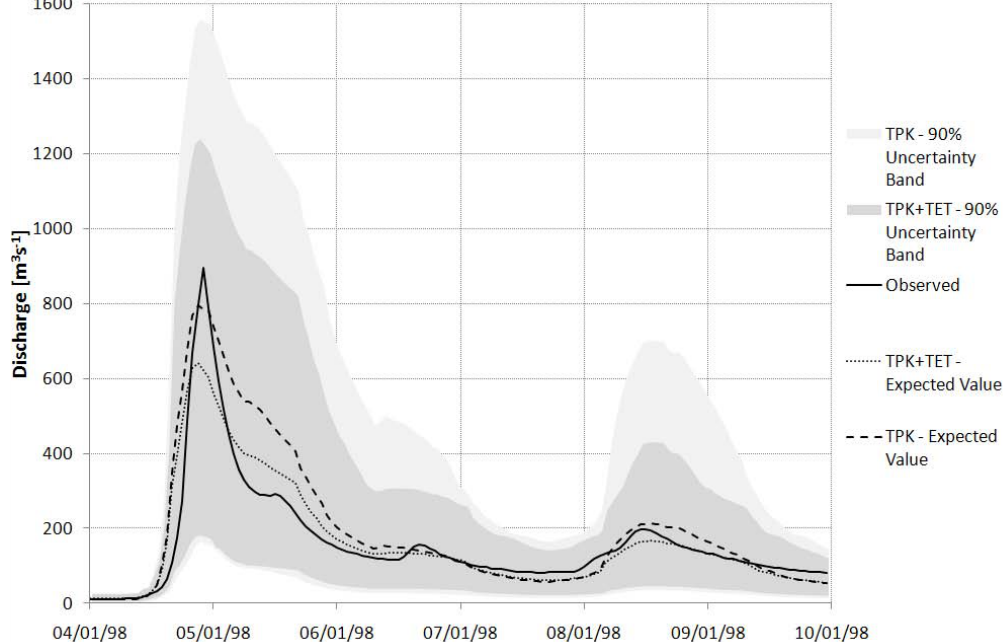
Fig. 15. Comparison between the PU computed with one or two models on a flood event for the validation period. Observed discharges (black line); expected value conditioned only to the TOPKAPI forecast (dashed line); expected value conditioned to the TOPKAPI and TETIS forecasts (dotted line); 90% uncertainty band conditioned to the TOPKAPI forecast (light grey band); 90% uncertainty band conditioned to the TOPKAPI and TETIS forecasts (grey band).